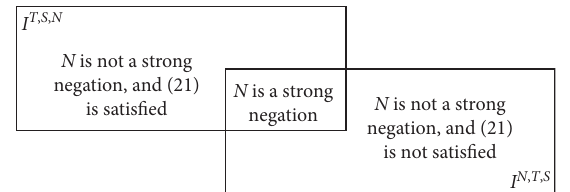
Figure 2: Intersection between families of D - and D ′ -operations (respectively,